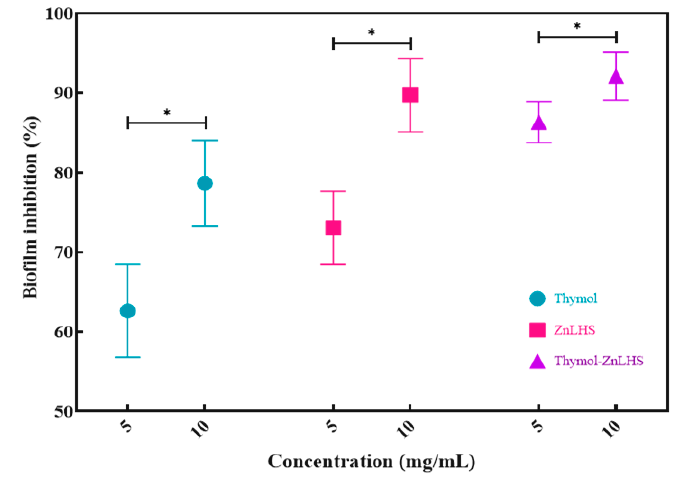
Figure 9. Biofilm inhibition of Pseudomonas aeruginosa (%). Significant differences were based on LSD Fisher post hoc paired comparisons (* p < 0.05).